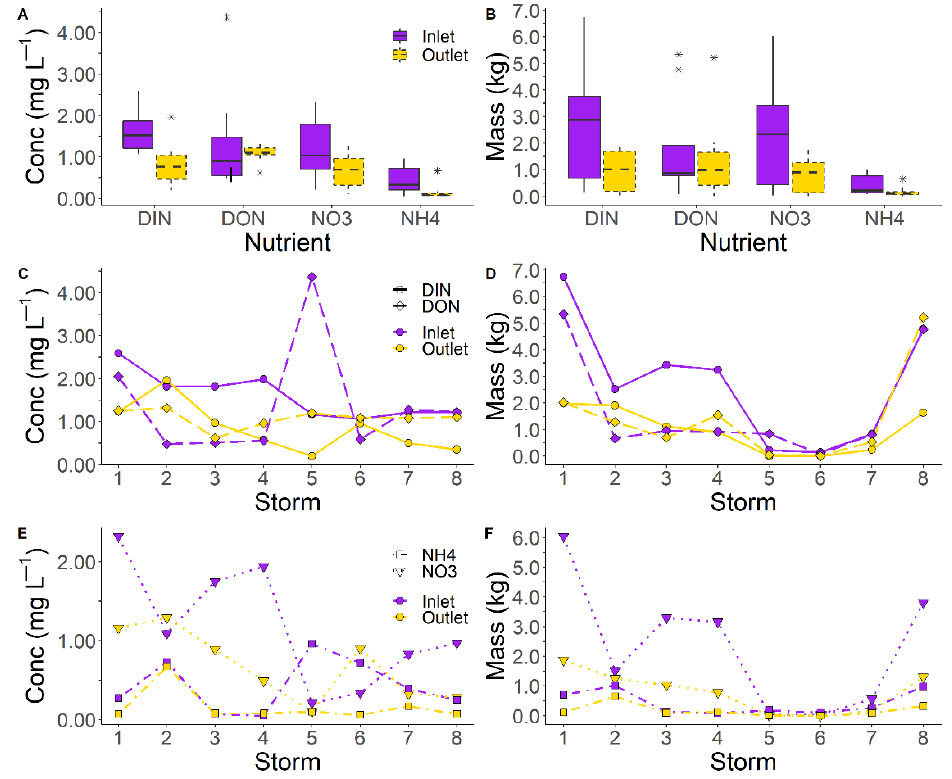
Figure 7. Box plots ( A , B ) and time series ( C – F ) of event mean concentrations and mass loadings of dissolved inorganic nitrogen (DIN), dissolved organic nitrogen (DON), NO 3 − , and NH 4 + at the inlet and outlet of the dry detention basin. Statistical outliers are shown as (*).